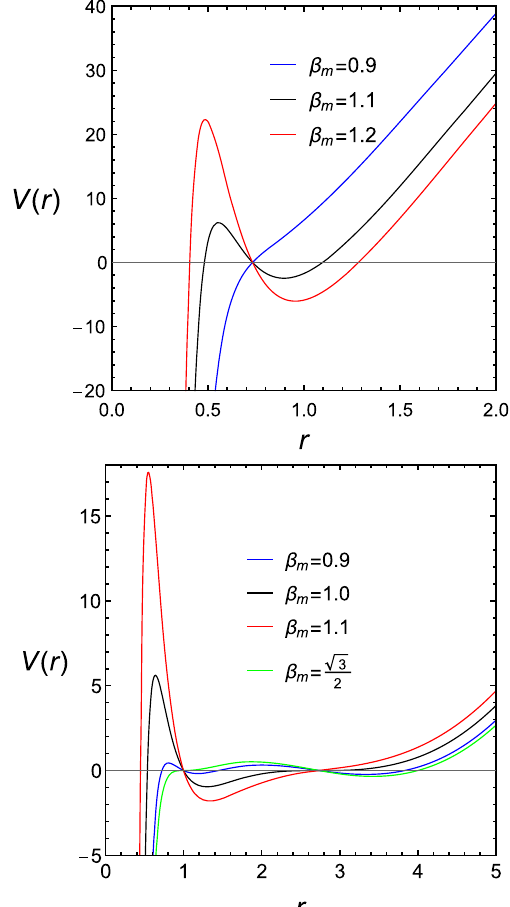
Fig. 3 TheleftpanelshowsthepotentialfortheasymptoticdSsolution with (cid:16) = 0, c 2 = − 1, M = 1. The right panel shows the potential for the asymptotic AdS solution with (cid:16) = 0, c 2 = 1, M = 1